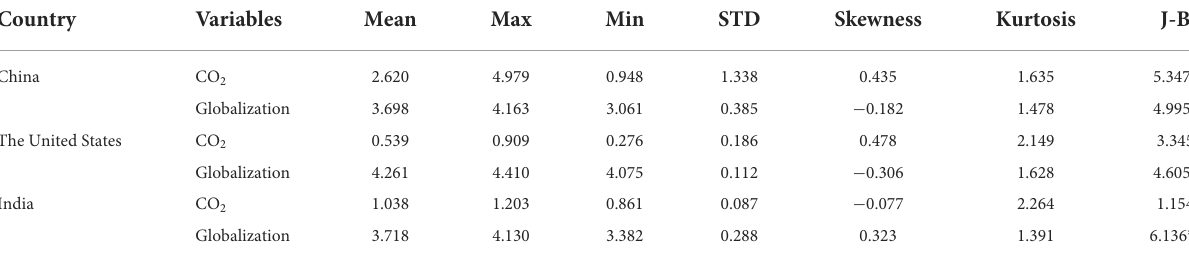
TABLE 1 Summary statistics of the variables. Country